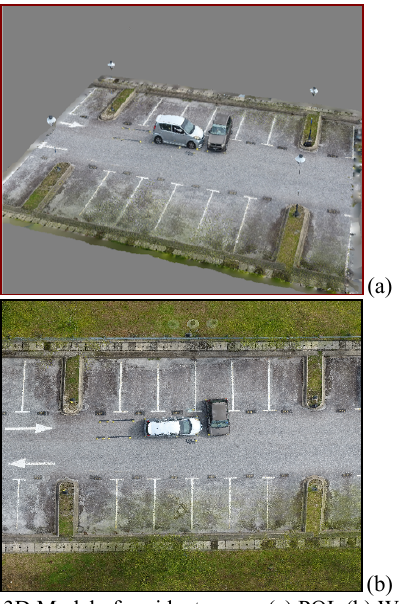
Figure 8. 3D Model of accident scene; (a) POI, (b) Waypoints The accuracy assessment analysis used 33 points to measure a few sample of distances. The same distances also are measured using tools in Agisoft Metashape. These two types of measurements were compared with the same distances calculated directly from the points. Figure 9 shows the images of accident scene taken by a police investigator with a digital camera. Every detail at the accident scene needs to be captured for investigation and to model the accident by forensics at the laboratory.